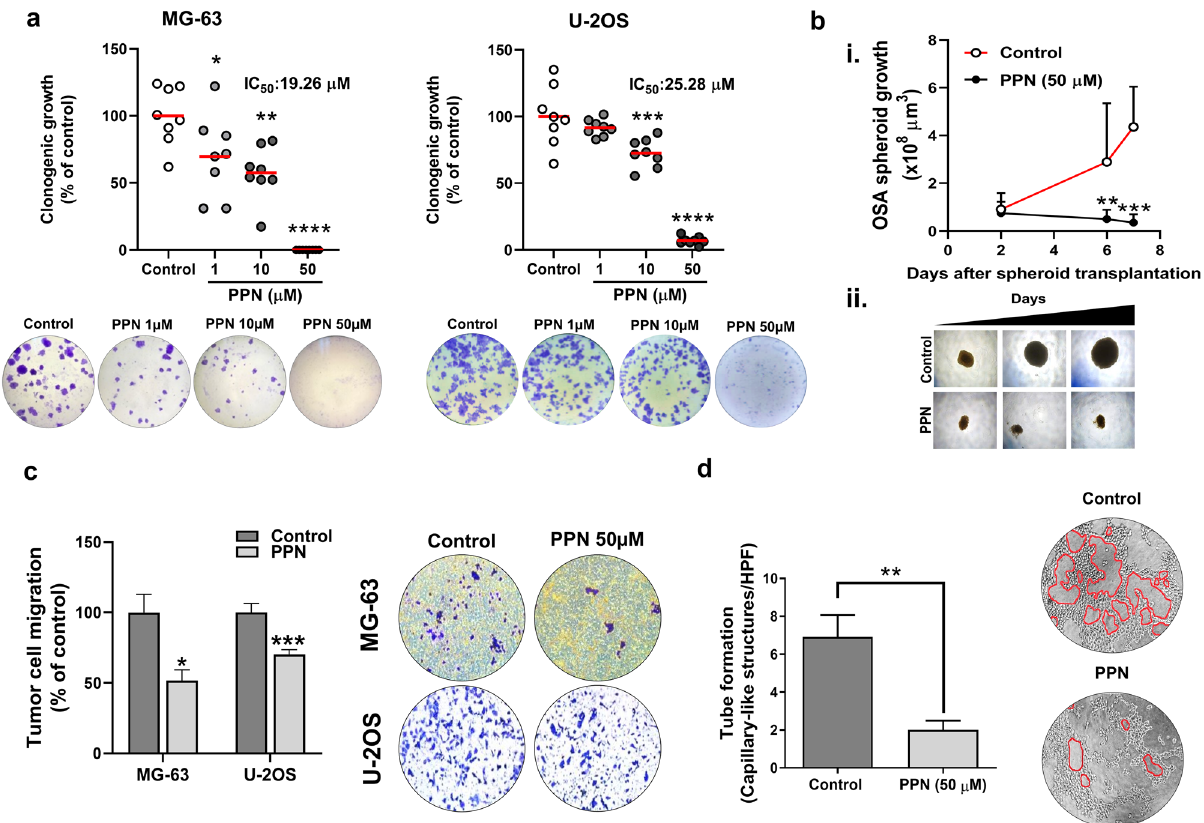
Figure 2. Propranolol abrogates colony formation, three-dimensional spheroid growth, cell migration and tube formation in osteosarcoma. ( a ) Number of osteosarcoma (OSA) colonies per well quadrant was quantified after a 7 day incubation with propranolol (PPN, 1–50 µM). Representative microphotographs of MG-63 and U-2OS clonogenic cultures (bottom) in control and PPN 1, 10 and 50 µM groups (left to right) are depicted. ( b ) PPN completely impairs growth of fully formed OSA spheroids. (i) OSA spheroid volume was assessed as a direct parameter of spheroid growth during the following week. (ii) Representative images of OSA spheroids at days 2, 6 and 7 (left to right). ×40 final magnification. ( c ) Inhibition of MG-63 and U-2OS cell chemotaxis after a 16 h treatment using PPN at 50 µM. Representative pictures of tumor cells on the bottom of the Transwell inserts (bottom) corresponding to the control or PPN group (left and right, respectively) are shown. ( d ) Inhibition of capillary-morphogenesis on a Matrigel-coated substrate by MG-63 cells after 16 h treatment with PPN 50 µM. Representative images of capillary-like tubular structures (identified in red lining) in different experimental conditions (×100 magnification). * p < 0.05, ** p < 0.01, *** p < 0.001 and **** p < 0.0001. ANOVA followed by Tukey’s test for ( a ), unpaired two-sided t test for ( b ) and ( c ) and Mann–Whitney test for ( d